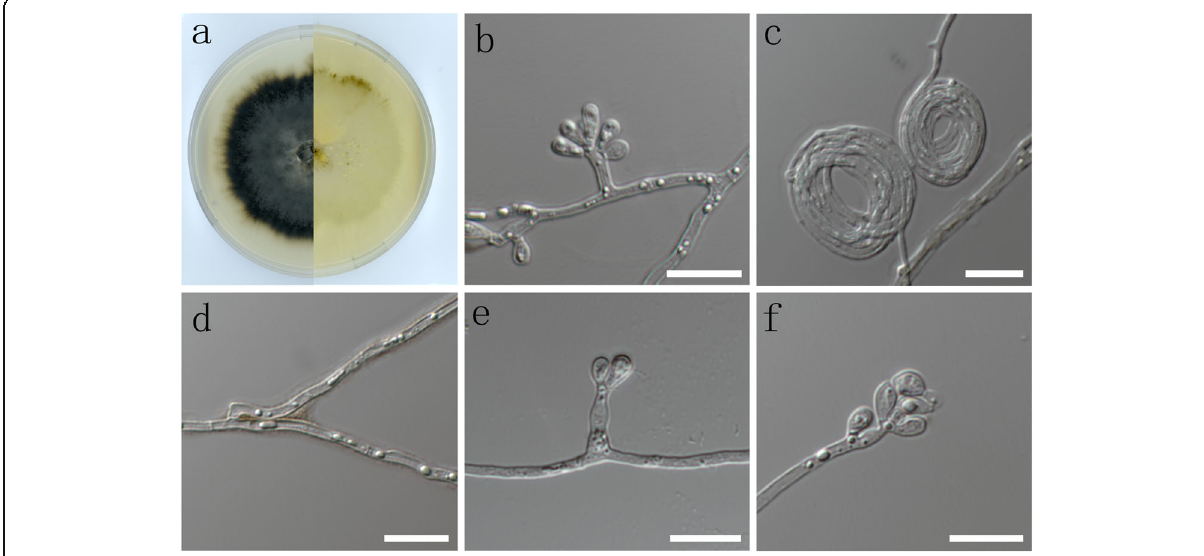
Fig. 7 Morphological characters of asexual structure of Ophiostoma manchongi sp. nov. a Cultures on malt extract agar (MEA); b , e , f conidiogenous cells and conidia; c , d mycelium. – Scale bars: 10 μ